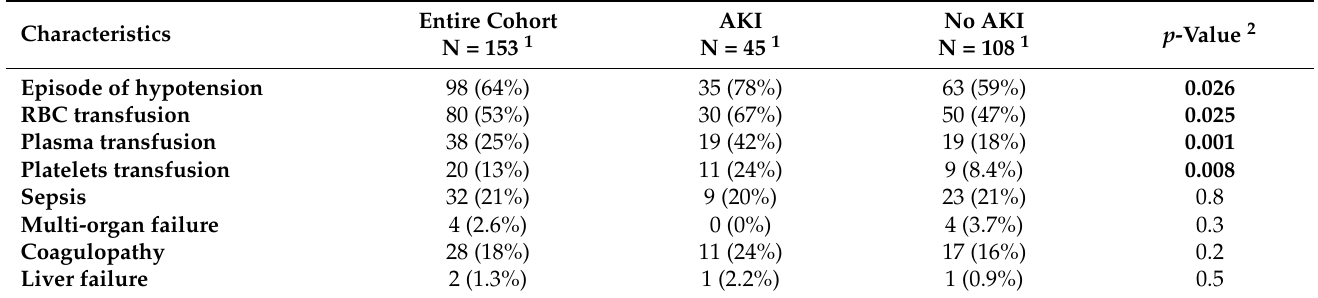
Table 6. Adverse events during ICU stay in the overall population and according to development of AKI.